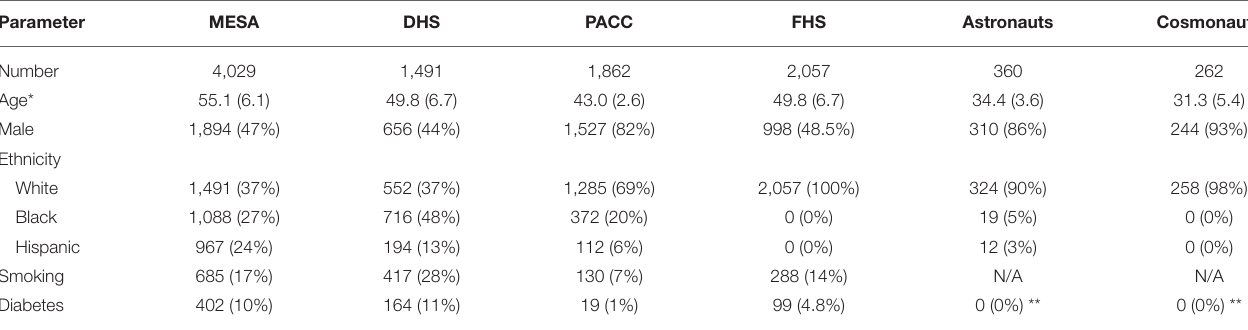
TABLE 4 | Demographic characteristics of the Astro-CHARM/Multimodality risk tool cohorts and astronauts/cosmonauts (21, 22, 89). Parameter